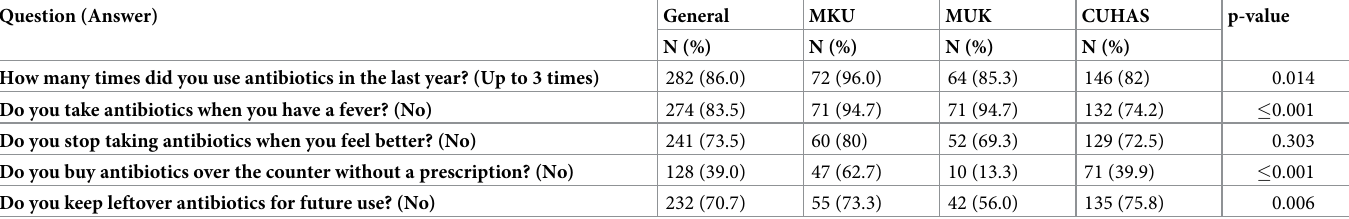
Table 5. Attitude and perception on antibiotic